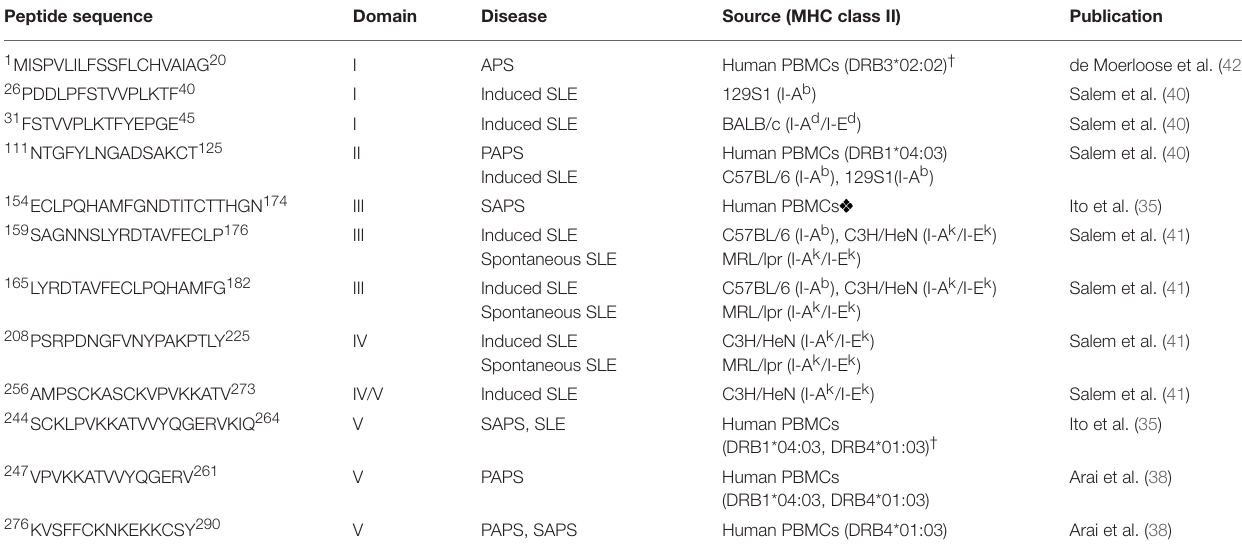
TABLE 1 | β 2GPI CD4 + T cell epitopes identified in APS and SLE. Peptide